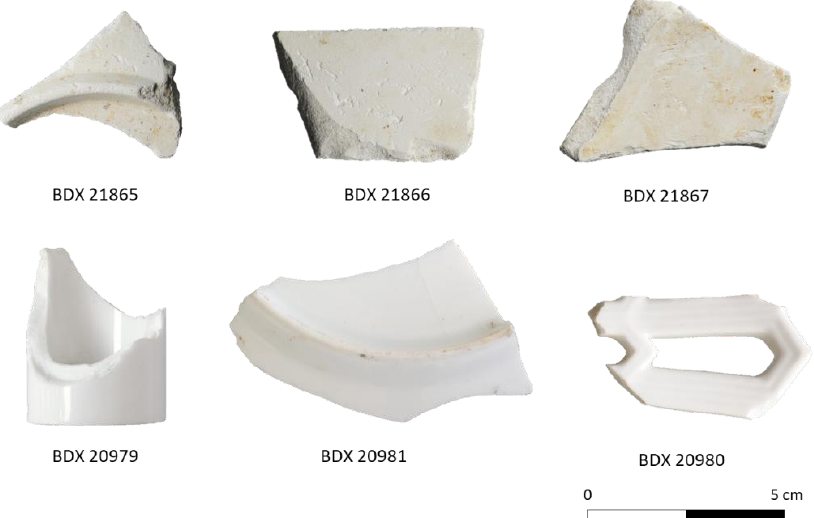
Figure 1. Some examples representative of the analyzed samples: biscuits of porcelain at the top and porcelains at the bottom.